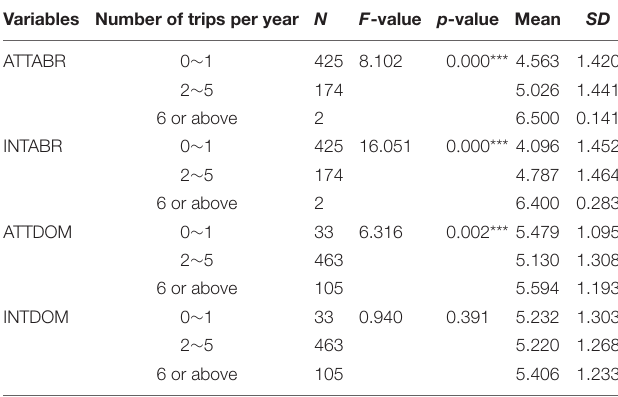
TABLE 7 | Results of ANOVA (number of